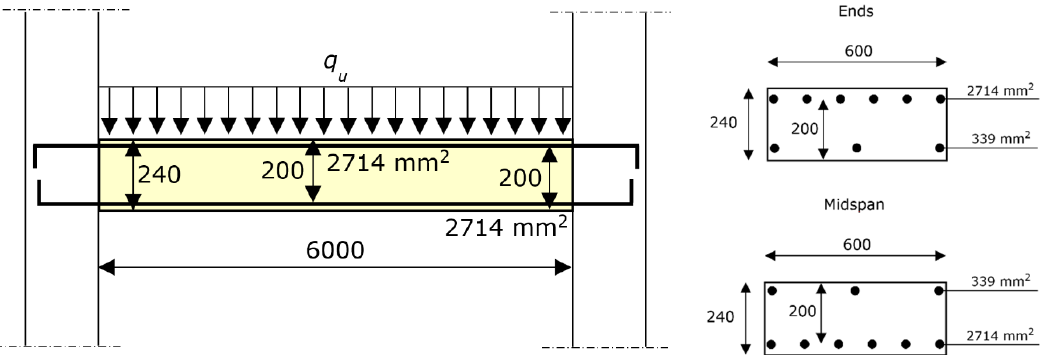
Figure 7. RC beam considered as an applicative example. On the left : longitudinal section. On the right : cross-sections at the ends (above) and at the midspan (below). The dimensions are expressed in millimeters. The figure also shows the amount of reinforcement at the ends and at the midspan, which are